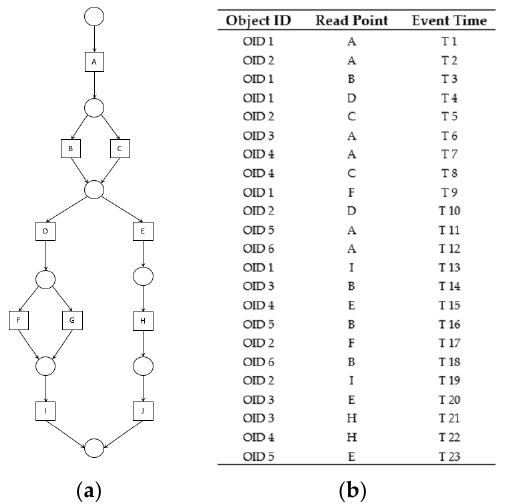
Figure 2. Example of process model and flat-formatted event log. ( a ) process model; ( b ) flat-formatted event log.